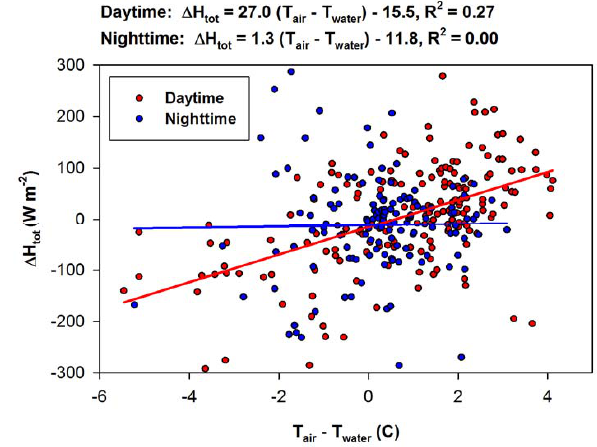
Fig. 7. Daytime and nighttime total enthalpy change in the water column ( H tot (W m -2 )) as a function of the temperature difference between air temperature (T air (C)) at 27 m and average water temperature (T water (C)). The slope of the least squares regression line was significantly different that zero during daytime periods (p<0.01, N=181) but not during nighttime periods (p=0.84, N=137).